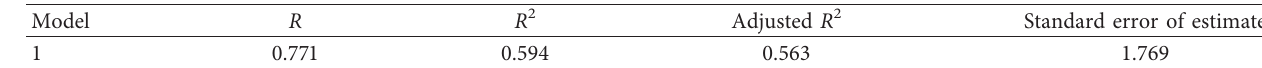
Table 7: Degree of fitness of the calibrated model.